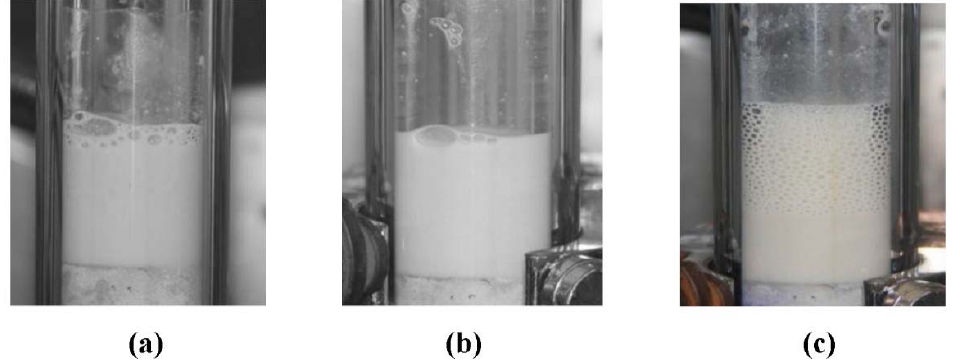
Figure 4. The morphology of the ZIF ‐ 8/water ‐ glycol slurry during the separation of a C 3 H 6 /H 2 mixture. ( a ) Fresh ZIF ‐ 8/water ‐ glycol slurry; ( b ) separation equilibrium slurry; and ( c ) gas desorption process for the slurry.